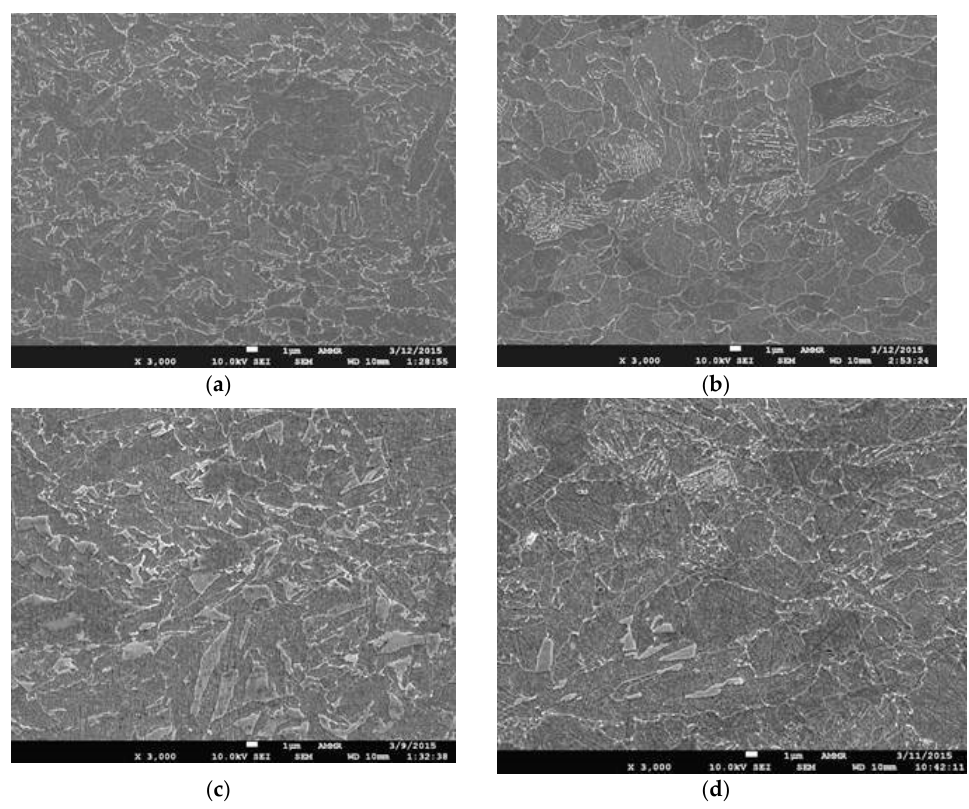
Figure 7. Selected microstructures for the Nb steel ( a , c ) and the TiMo steel ( b , d ) with a coiling temperature of 500 °C ( a , b ) and 600 °C ( c , d ); rolling schedule ( a ) in Figure 2d.